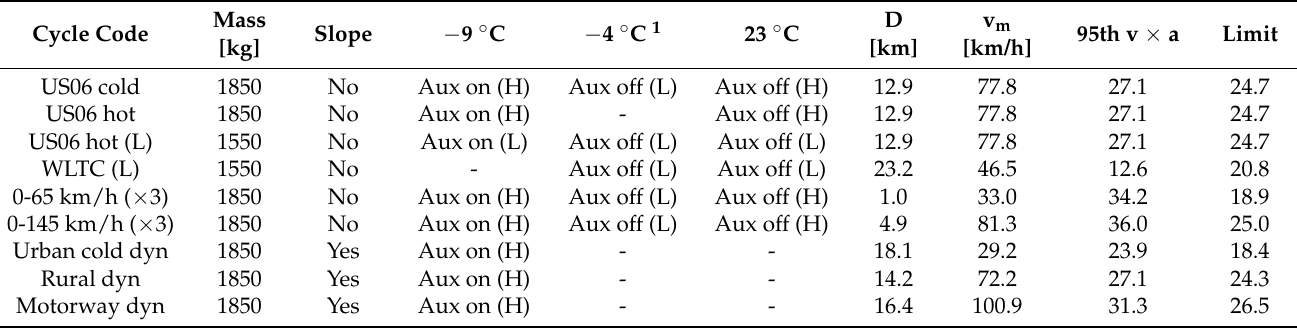
Table 3. Test cycles and conditions. “Aux on” means that air-conditioning was on, heating at the two front seats and heating of the rear windows (windshield). (L) corresponds to tests with 28% payload and 1550 kg mass. (H) corresponds to tests with 84% payload and 1850 kg mass (the dyno friction coefficient was also adjusted). “Limit” gives the maximum allowed 95th v × a value for the specific trip (mean speed). D = Distance; v m = mean